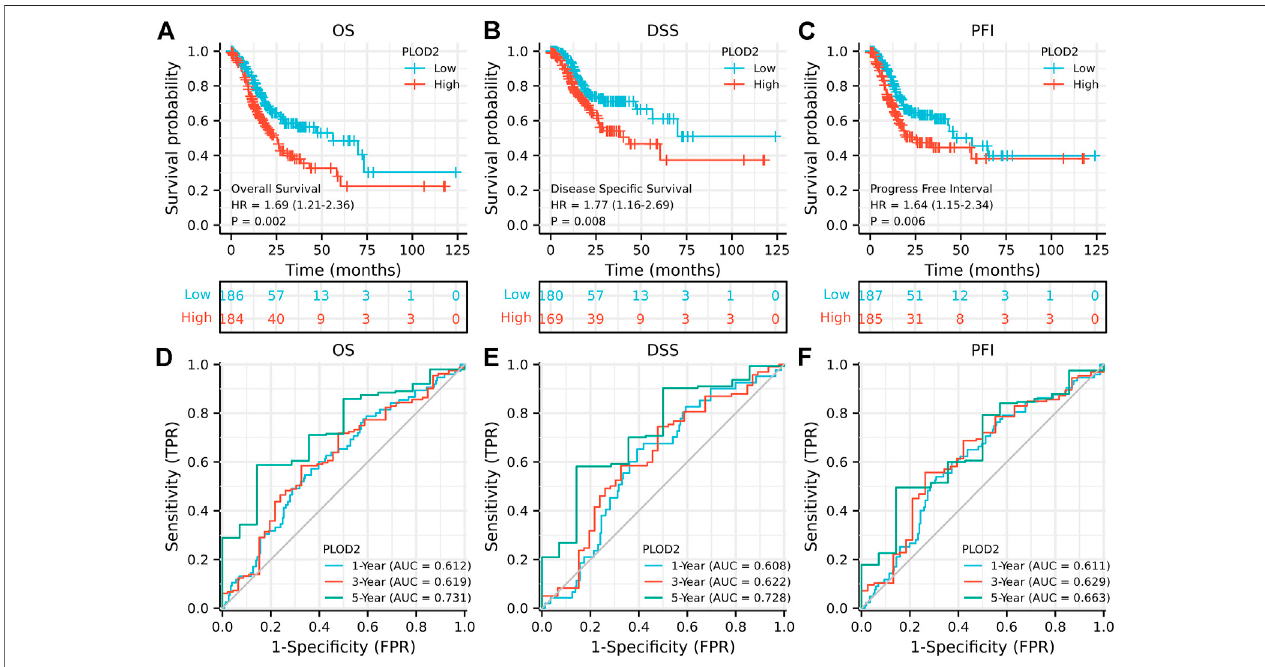
FIGURE2| Prognosticanalysisof PLOD2 genesignatureinSTADintheTCGAset. (A) overallsurvival (B) disease-speci fi csurvival (C) progression-freeinterval (D) ROC of overall survival (E) ROC of disease-speci fi c survival (F) ROC of progression-free